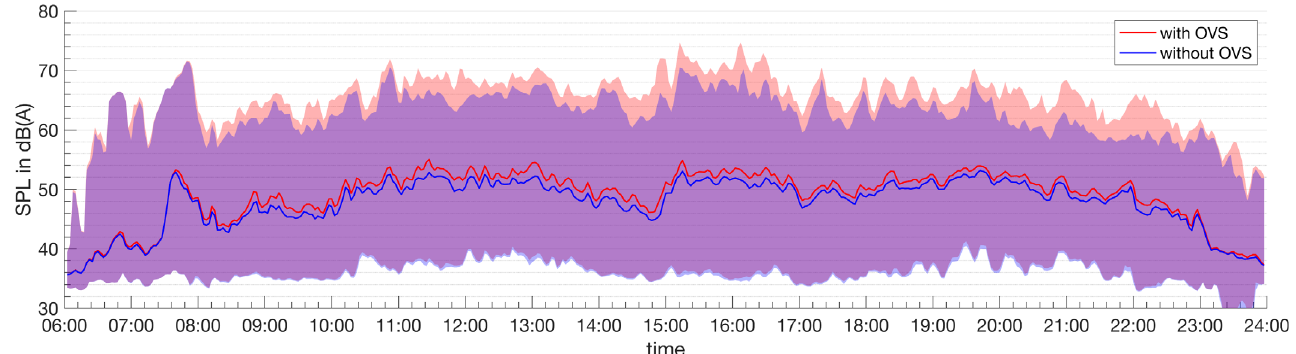
Figure 5. Time course of the A-weighted SPL in intervals of 5 min with 50% overlap, averaged over all participants and recording days. The solid lines give the median values and the shaded areas cover the 10th to 90th percentiles. Results including OVS are given in red and results excluding OVS are given in blue.